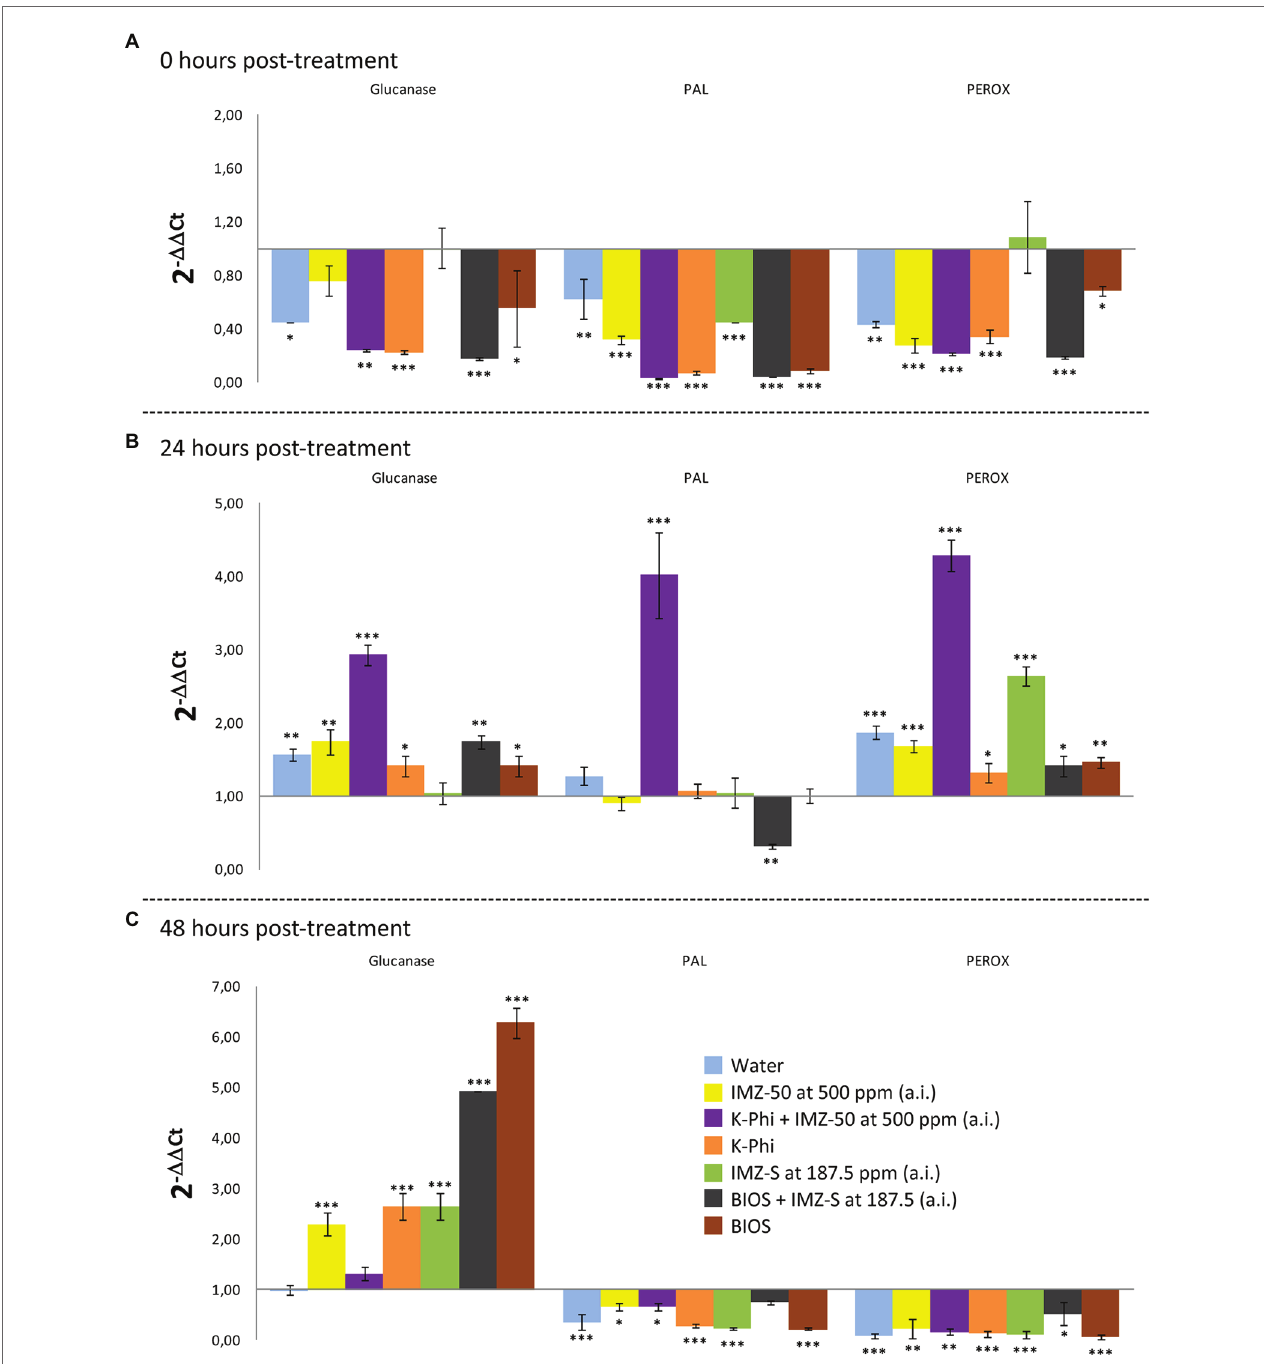
FIGURE 5 | Differences in the expression levels of β -1,3-glucanases-, PAL-, and PEROX-encoding genes in fruits of sweet orange ( Citrus sinensis ) fruits cv. Moro nucellare wounded and treated with water or IMZ-50 (emulsifiable concentrate formula at 50% w/v of active ingredient - a.i.) at 500 ppm a.i., IMZ-S (formula at 7.5% w/v of a.i.) at 187.5 ppm a.i., K-Phi formula (57% w/v) at the dosage of 0.25%, BIOS formula at the dosage of 0.15%, Mixture A (K-Phi: 0.25%; IMZ-50: 500 ppm a.i.), and Mixture B (BIOS: 0.15%; IMZ-S: 187.5 ppm a.i.) at 0 (A) , 24 (B) , and 48 (C) h after treatment. Columns with asterisks are statistically different according